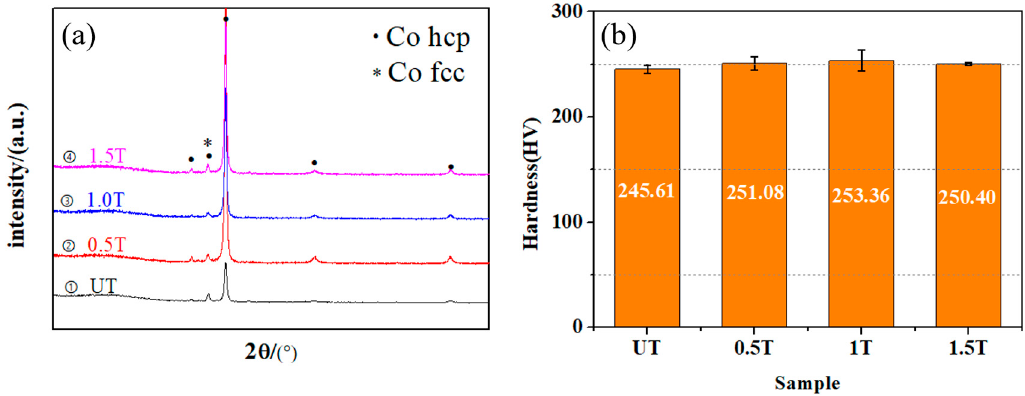
Figure 2. XRD ( a ) and hardness ( b ) of samples after PMT using the 0–1.5T processing parameters.